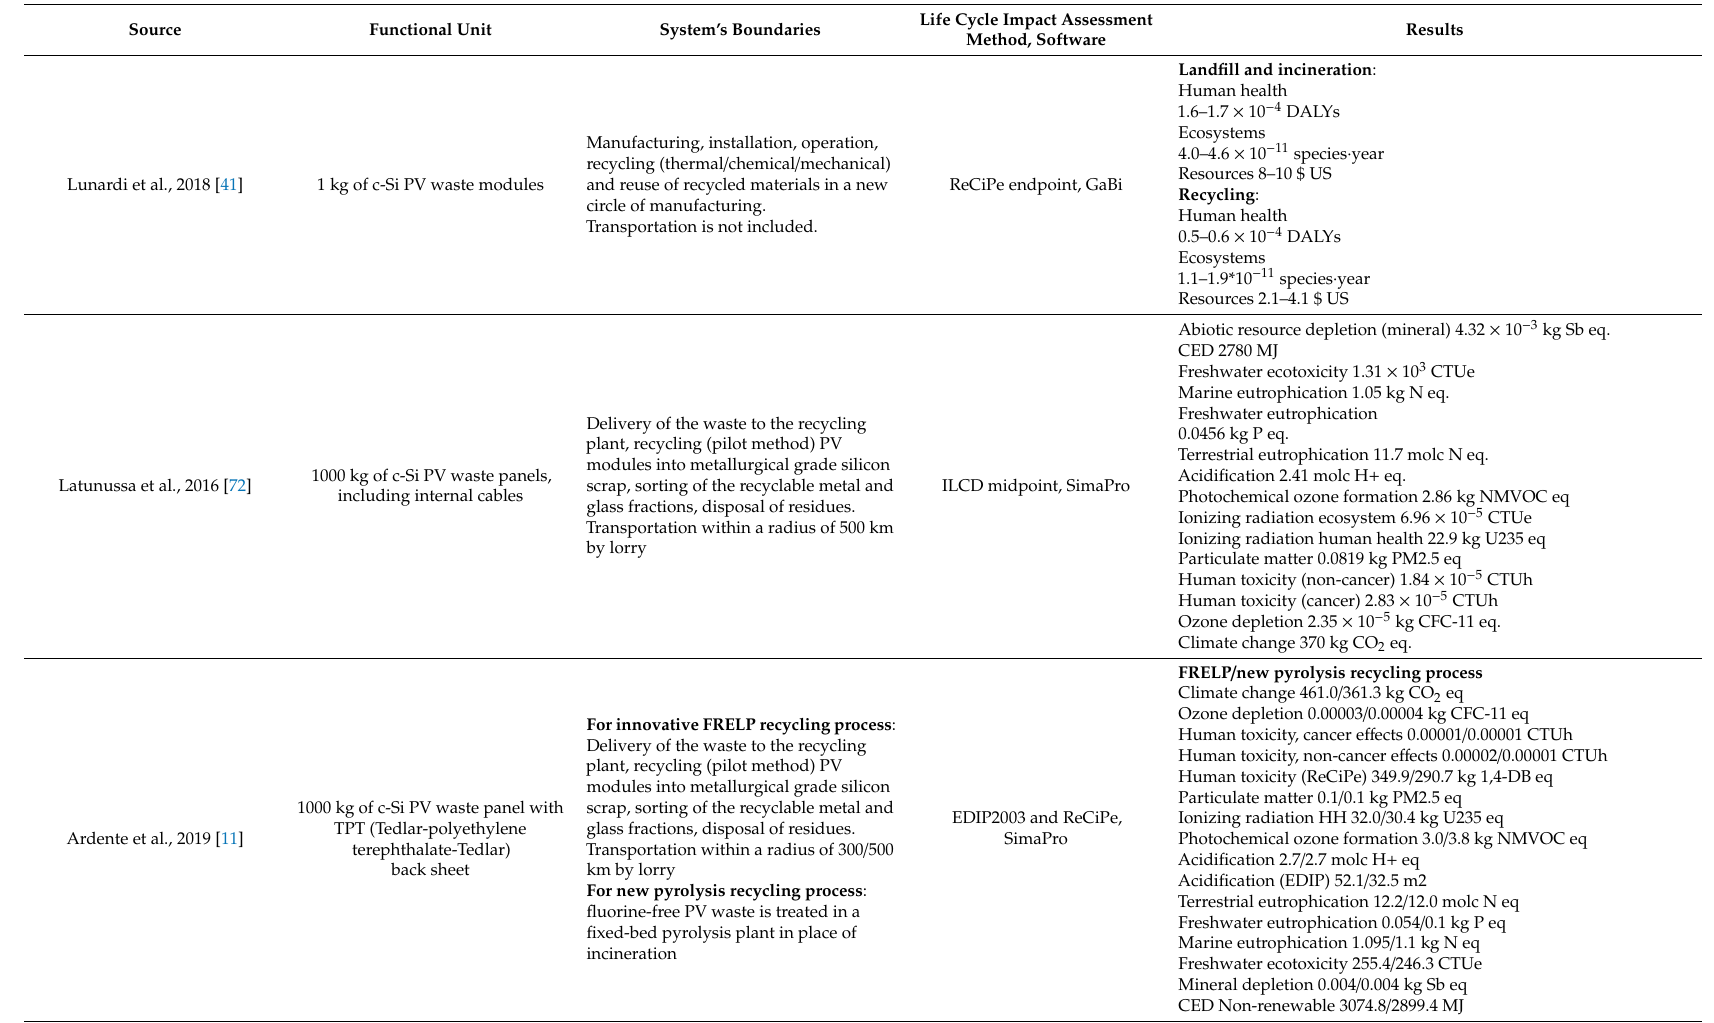
Table 2. Life cycle assessment (LCA) results for PV